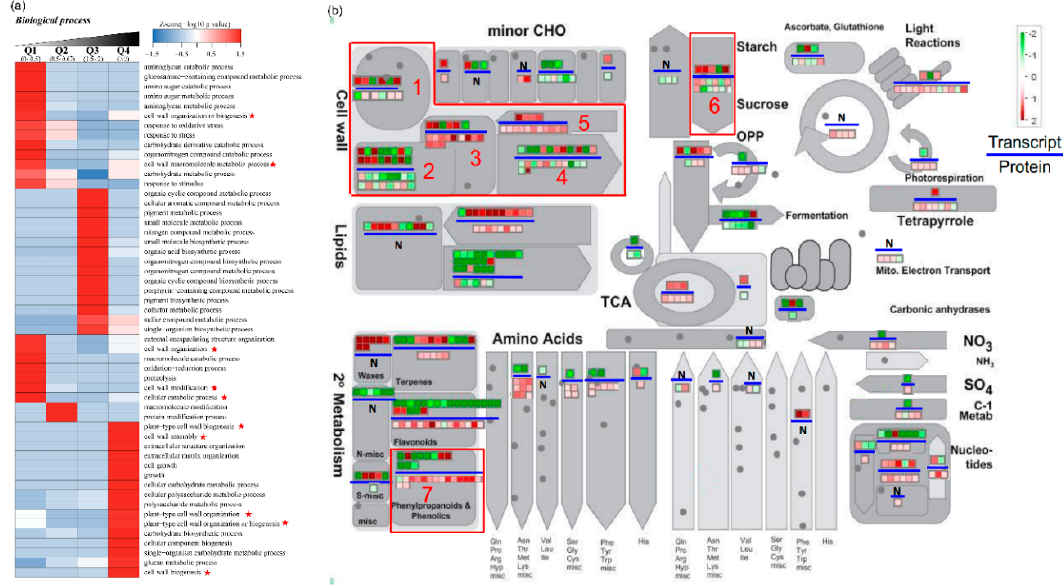
Figure 6. GO and MapMan analysis the function of DEGs and DEPs in lotus. ( a ) Function enrichment analysis of proteins with significant changes in abundance between IFP and IVP. Abundance of 164 proteins in IFP was 2-fold higher than IVP (Q1) and abundance of 257 proteins in IFP was 1.5–2-fold higher than IVP (Q2). Also, abundance of 346 proteins in IVP was 1.5–2-fold higher than IFP (Q3) and abundance of 137 proteins in IVP was 2-fold higher than IFP (Q4). Red star indicates cell wall related process; ( b ) MapMan analysis shows that DEGs and DEPs in different metabolic pathways in lotus petioles. Red squares indicate enhancement and green squares were the opposite. Squares above the